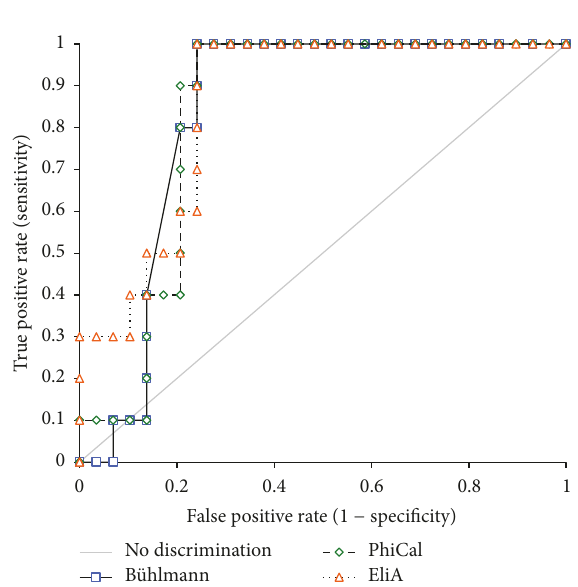
Figure 2: Receiver operating characteristic (ROC) curve of fecal calprotectin(FCal) .ROCofFCalcomparingB¨uhlmannCalprotectin ELISA, PhiCal Calprotectin-EIA, and Phadia 250 EliA-Calprotectin with colonoscopy in 40 pediatric fecal samples. The solid line indicates values that have no discrimination. The performance of a test that exhibits the highest sensitivity and specificity shows an optimum cut-off value to evaluate the relapse of